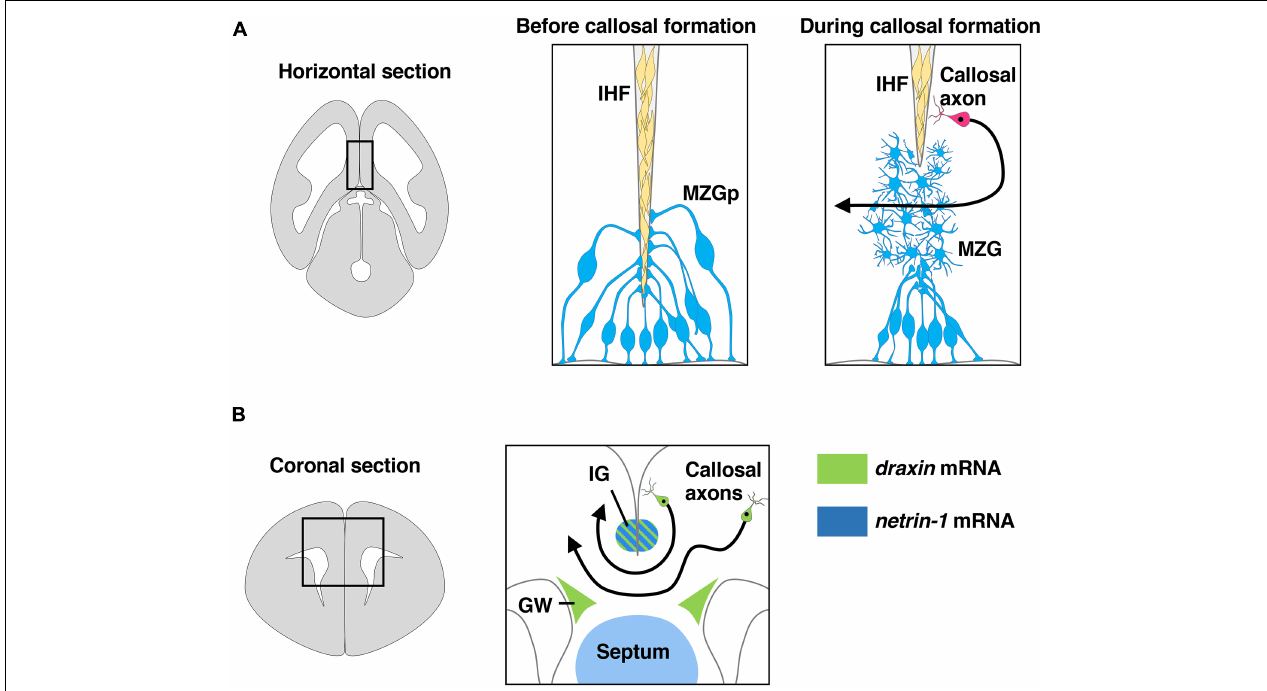
FIGURE 3 | Draxin and netrin-1 signaling in the development of corpus callosum. (A) The remodeling of the interhemispheric fissure (IHF) mediated by midline zipper glia (MZG) is necessary to form a permissive substrate for callosal axons to cross the midline. The area within the box in the left panel is shown in the middle panel and the right panel. Draxin, netrin-1, and Dcc are key players in IHF remodeling. MZGp, midline zipper glia progenitors. (B) Midline structures that express draxin and netrin-1 paly an essential role in guidance of callosal axons at the midline. The area within the box in the left panel is shown in the right panel. Draxin mRNA is expressed in the indusium griseum (IG) and glial wedge (GW), while netrin-1 mRNA is expressed in IG and septum. Draxin mRNA is also expressed in callosal